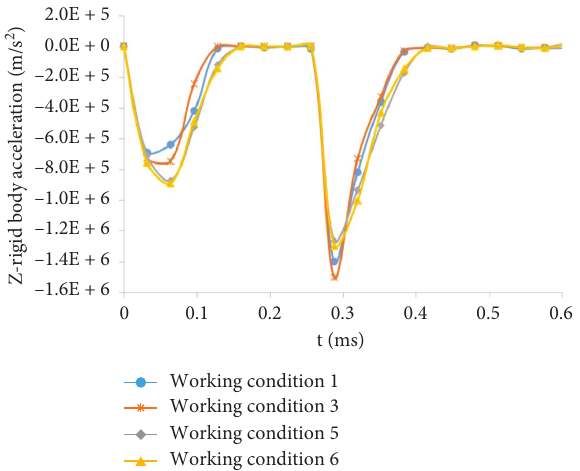
Figure 7: The change of the acceleration of the missile body.